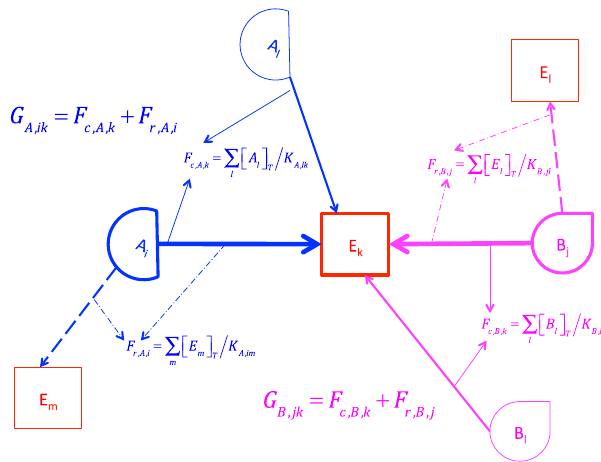
Figure 2. Graphic representation for the relationships between sub- strates, consumers, and normalized fluxes and their conjugates for a block unit of a large substrate–consumer network.